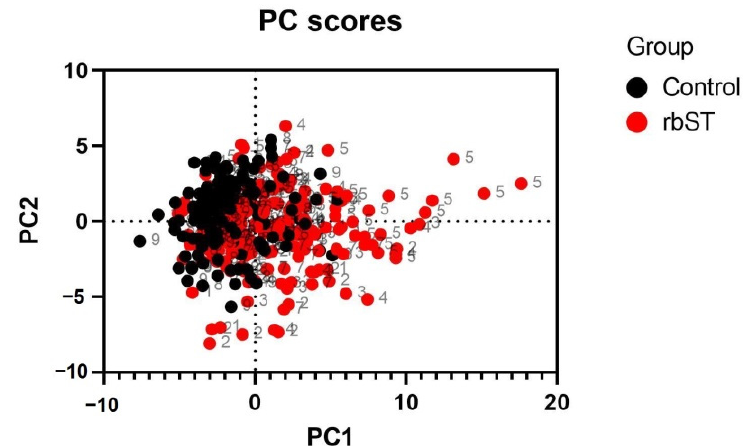
Figure 2. Principal component analysis scatter plot of the fatty acidome of bovine milk showing samples collected from control and recombinant bovine somatotropin animals at different time points during an experimental period of 240 days.